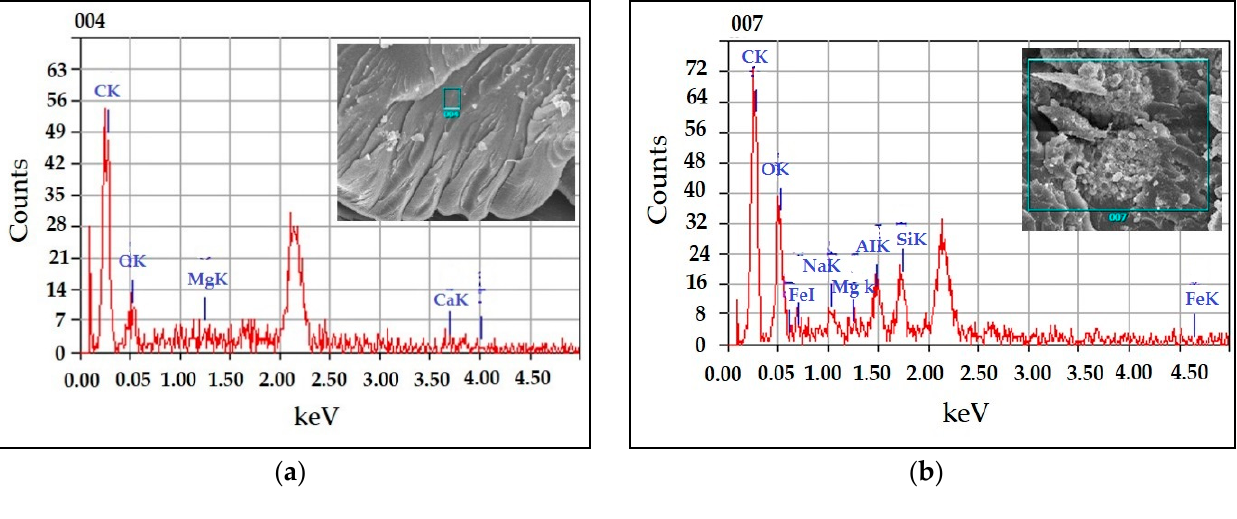
Figure 11. Effects of BR vol.% on the flexural strength and modulus of the BR–UPR composites.